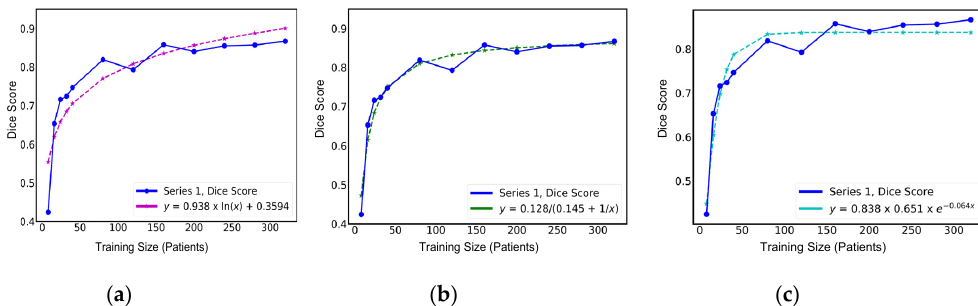
Figure 2. The mean Dice score at 12 different training sizes was approximated with several curve functions. ( a ) The first function was logarithmic with the formula y = a × ln ( x ) + b . a was 0.938 and b was 0.3594. The mean squared error was 2.55 × 10 − 3 . ( b ) The second function was asymptotic and used the formula y = a . a was 0.128 and b was 0.145. The mean squared error was 5.70 × 10 − 4 . ( c ) The third function was exponential with the formula y = 1 − a × e − b × x + c . a was 0.651, b was 0.064, and c was − 0.162. The mean squared error was 8.30 × 10 − 4 . The second function ( b ) provided the best approximation because it had the lowest mean squared error.